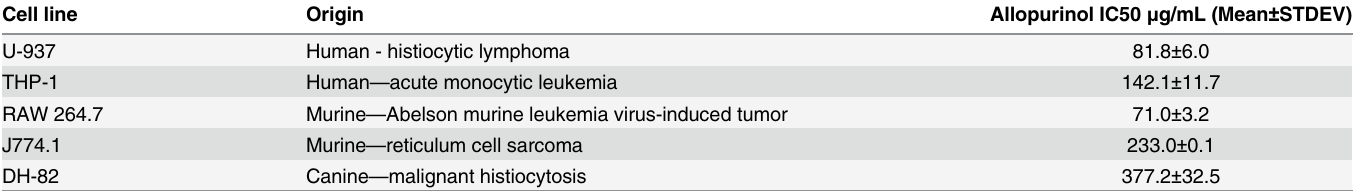
Table 2. Allopurinol toxicity for cell lines tested in this study. Cell